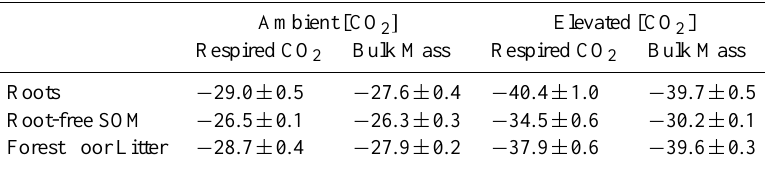
Table 1. The seasonal average 13 C signature of respired CO 2 and bulk mass from roots, root-free soil organic matter, and litter from control and treatment plots at FACTS-1. The average values listed here were derived from several day and night field incubations (see methods) for each collar location and for each time soil respiration and keeling plots were made in 2004 (June through September). Average values are expressed in per mil ± standard error ( n =